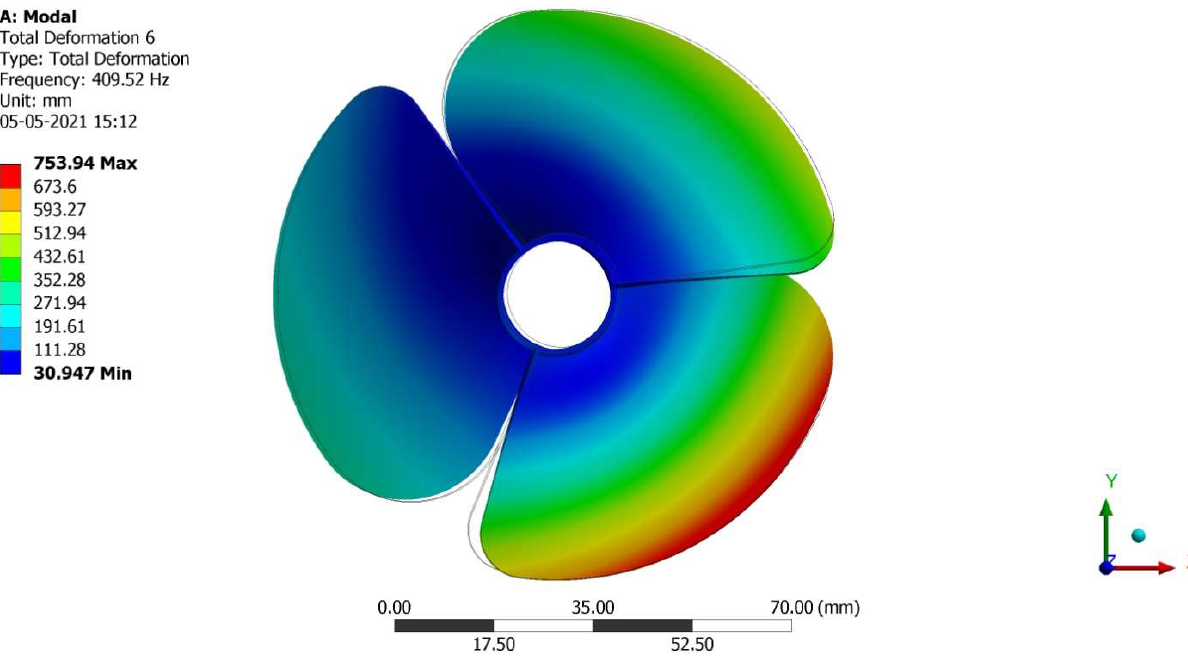
Figure 45. Sixth mode shape outcome of CFRP-woven-wet based composite.